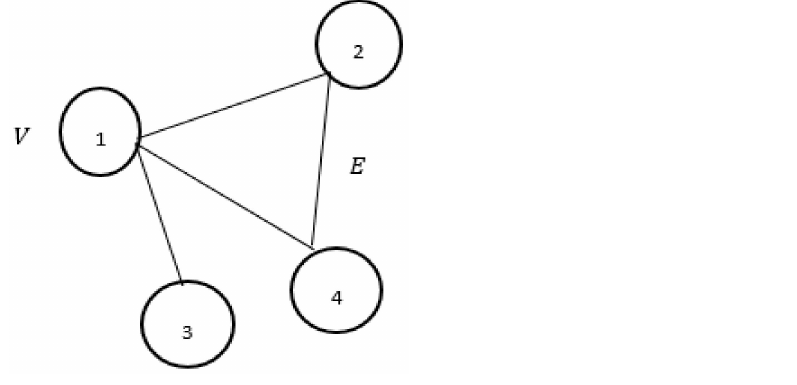
Figure 2. Agent i and neighbours j connected in a graph topology